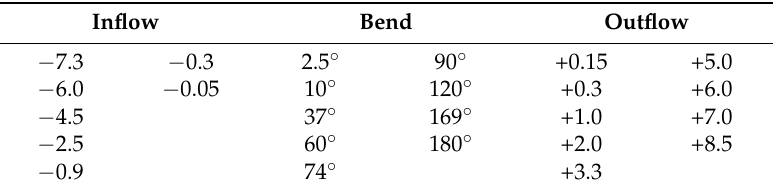
Table 2. Cross-sections of water surface